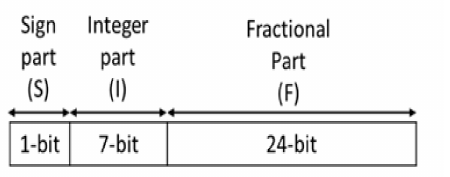
Figure 15. 32-bit fixed-point representation in a digital computer.